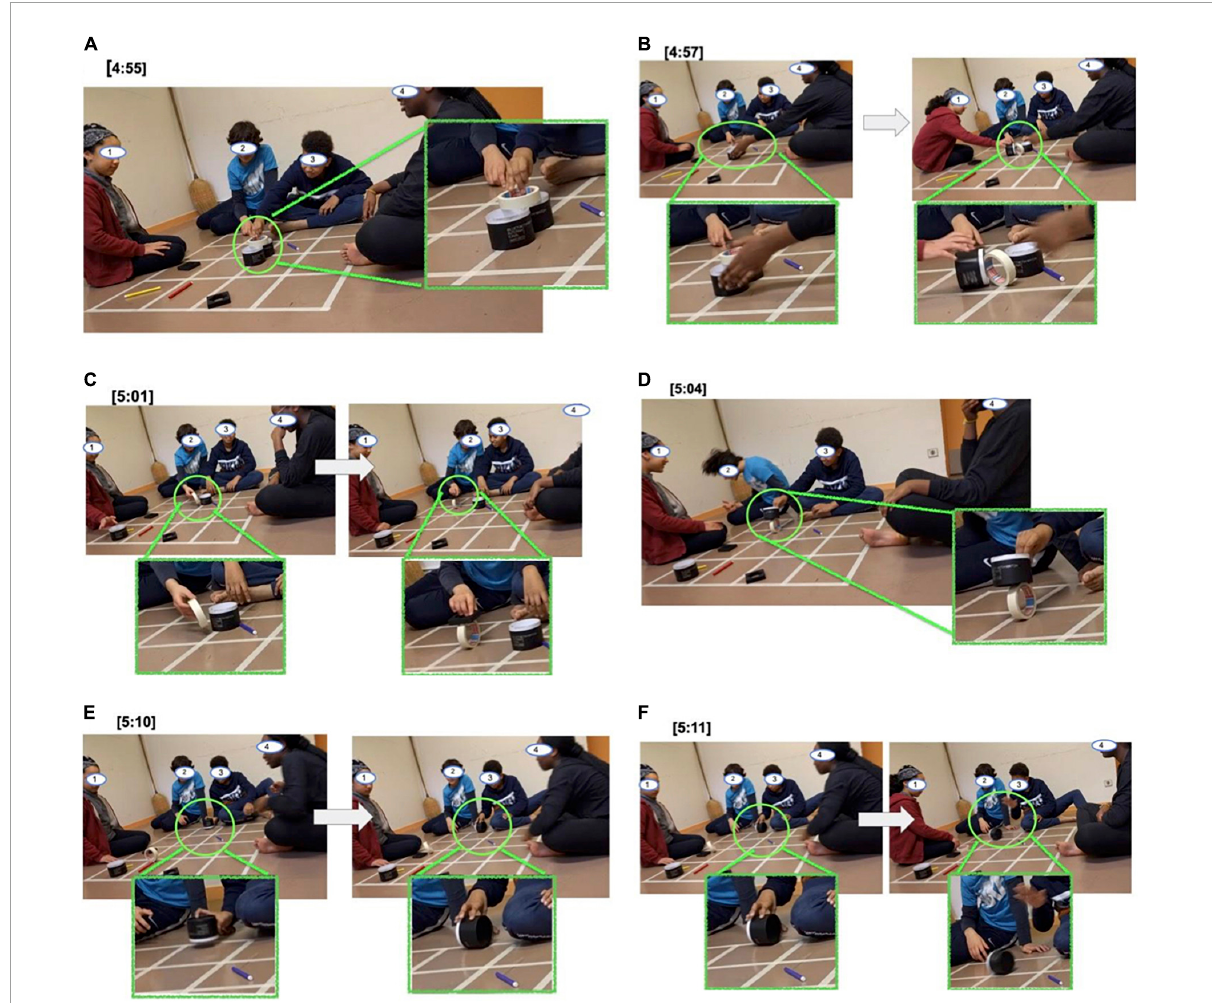
FIGURE6 Example of an accidental suggestion. (A) The players are engaged in a collective “tower building” proto-game. (B) Player 4 knocks down a construction but in doing so turns the roll of adhesive tape on its side (until that moment the tape was only placed on its flat base). (C) Player 2 stacks a black frame on the tape roll (now standing on its side). (D) Player 3 stacks a different object on top of the tape. (E) Player 3 turns the black box on its side. (F) Player 3 rolls the black